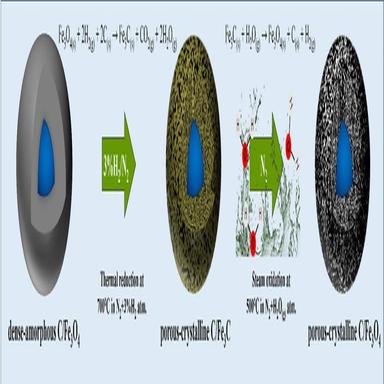
Synthesis scheme of the porous-crystalline C/Fe3O4 microspheres by spray pyrolysis with steam oxidation.